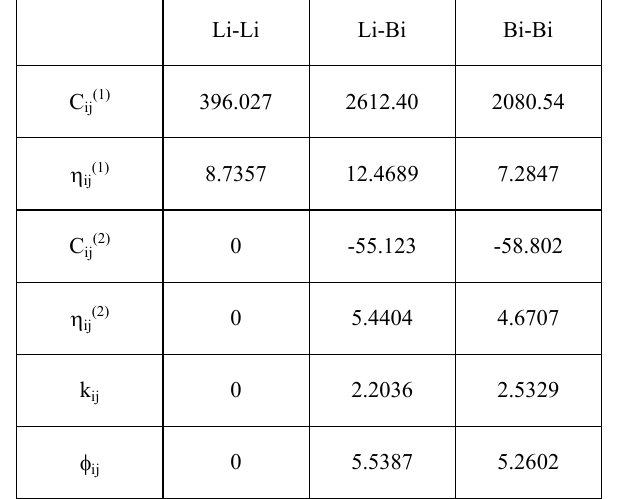
Fig. 2. Partial pair distribution functions obtained from ab-initio (VASP) and classical